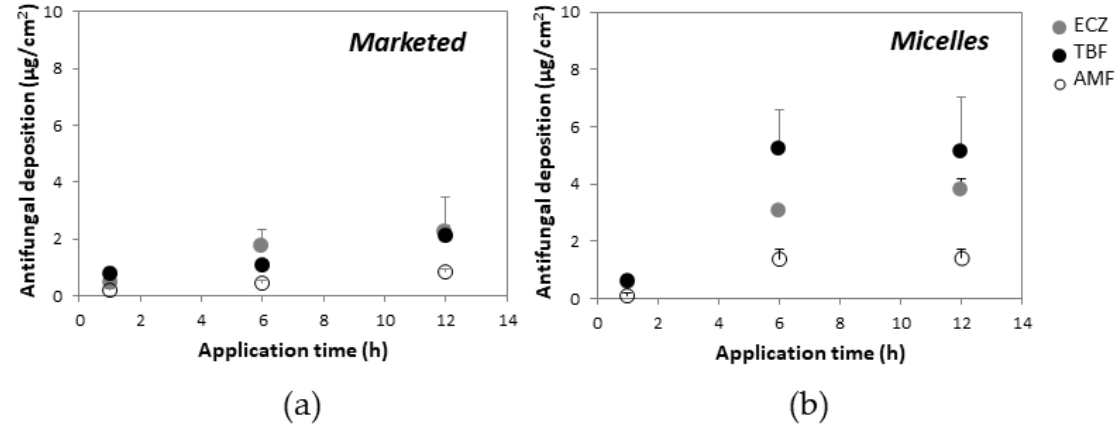
Figure 3. Antifungal deposition in porcine skin under infinite dose from ( a ) marketed formulations and ( b ) micelle-based formulation as a function of application time (mean ± SD, n ≥ 5), permeation was not detected (below LOQ (2.0 ng/mL)) after 12 h.